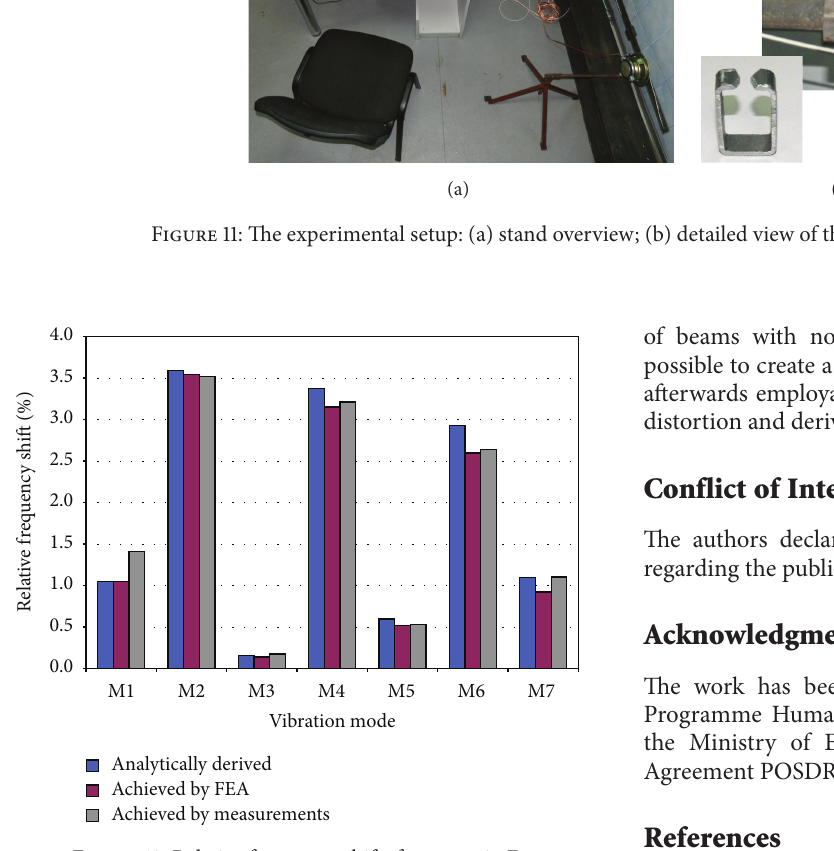
Figure 12: Relative frequency shifts for scenario